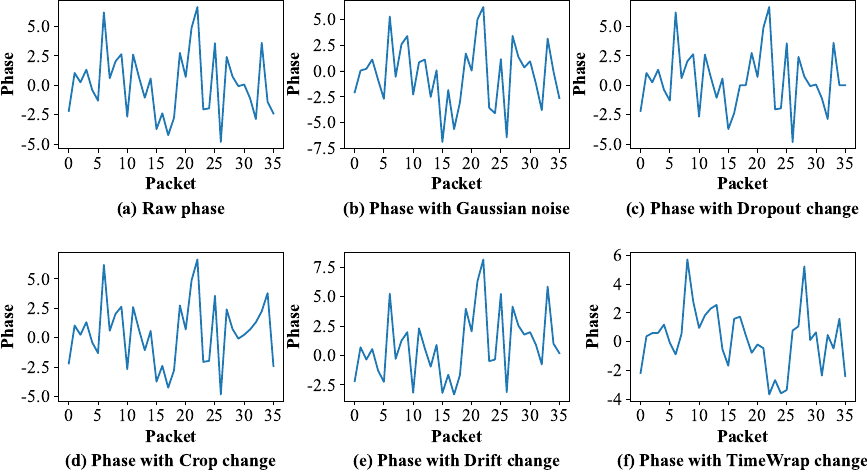
Figure 5. The effects of five data augmentation